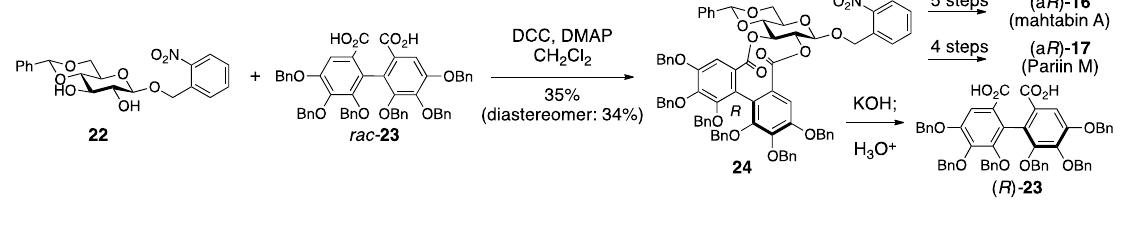
Figure 12. The significant HMBC relationships used for the determination of the structure 18 and 21 .